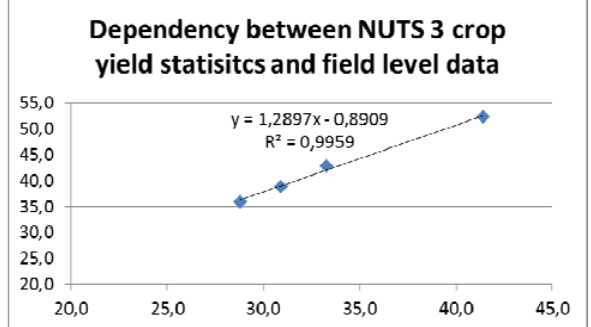
Figure 3. Linear dependency between county level statistics and field level crop yield data